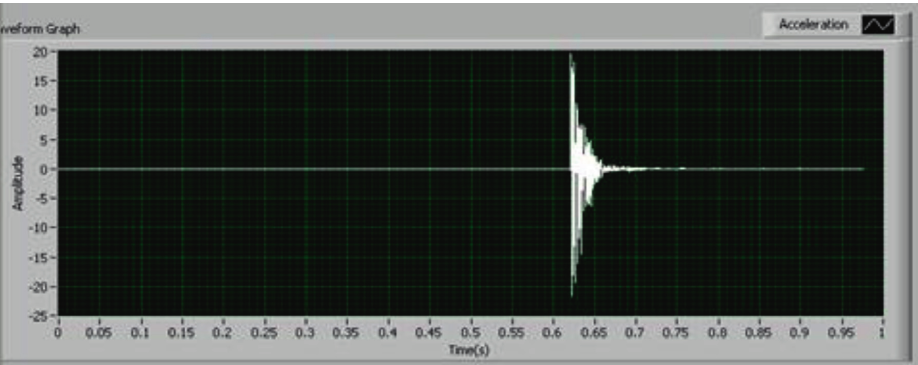
Figure 6: Time (sec) domain excitation response of A3 steel under loading condition